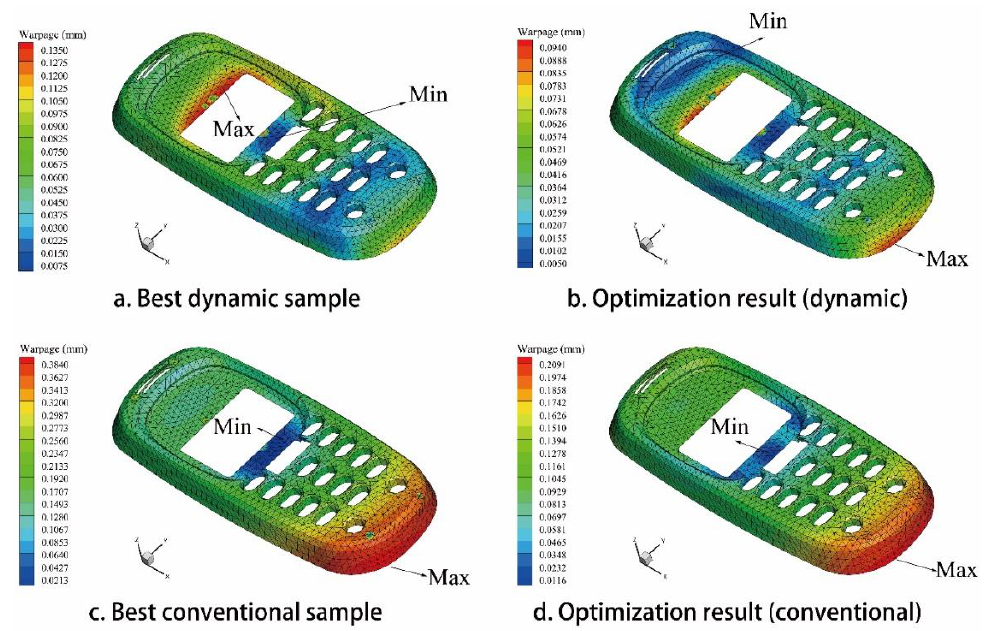
Figure 16. Warpage contours of the PC/ABS cellular phone cover model. ( a ) Best dynamic sample; ( b ) optimization result of the dynamic issue; ( c ) best conventional sample; and ( d ) optimization result of the conventional issue.